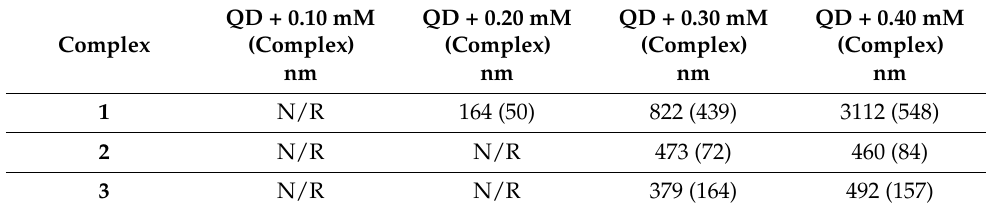
Table 2. Hydrodynamic sizes for QDs and complexes 1 – 3 from DLS measurements.